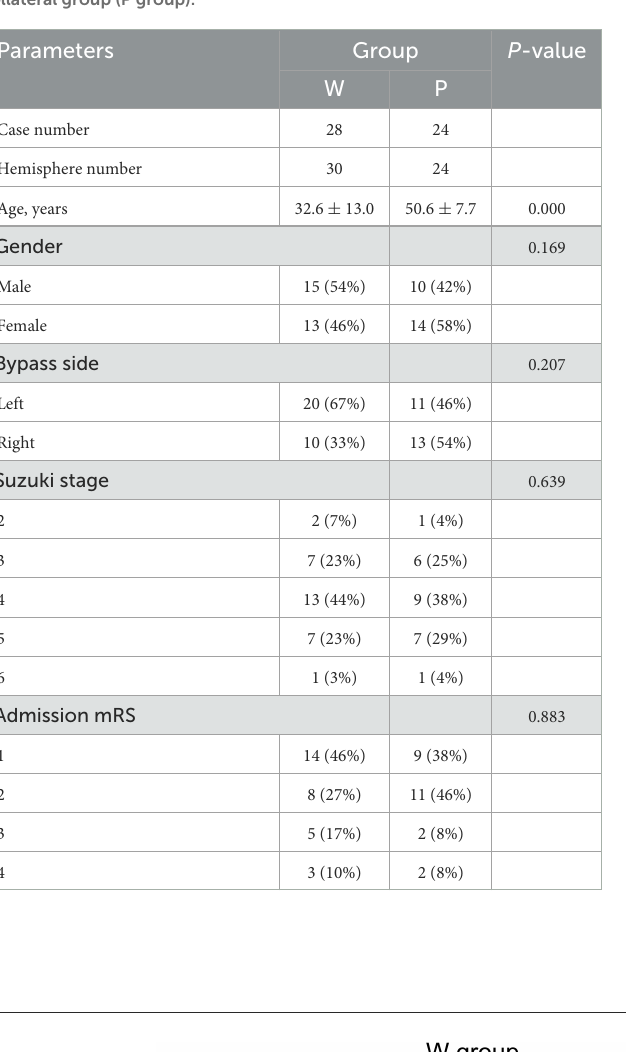
TABLE 1 Comparisons of the demographics and clinical characteristics of the well-compensated collateral group (W group) and poorly-compensated collateral group (P group).